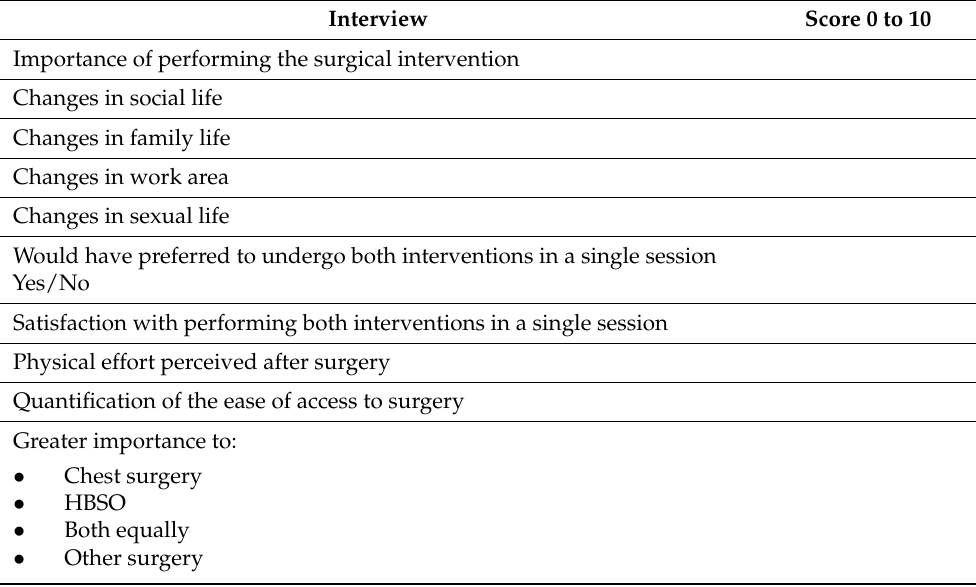
Table A1. Semi-structured interview performed to investigate satisfaction of subjects after surgery.